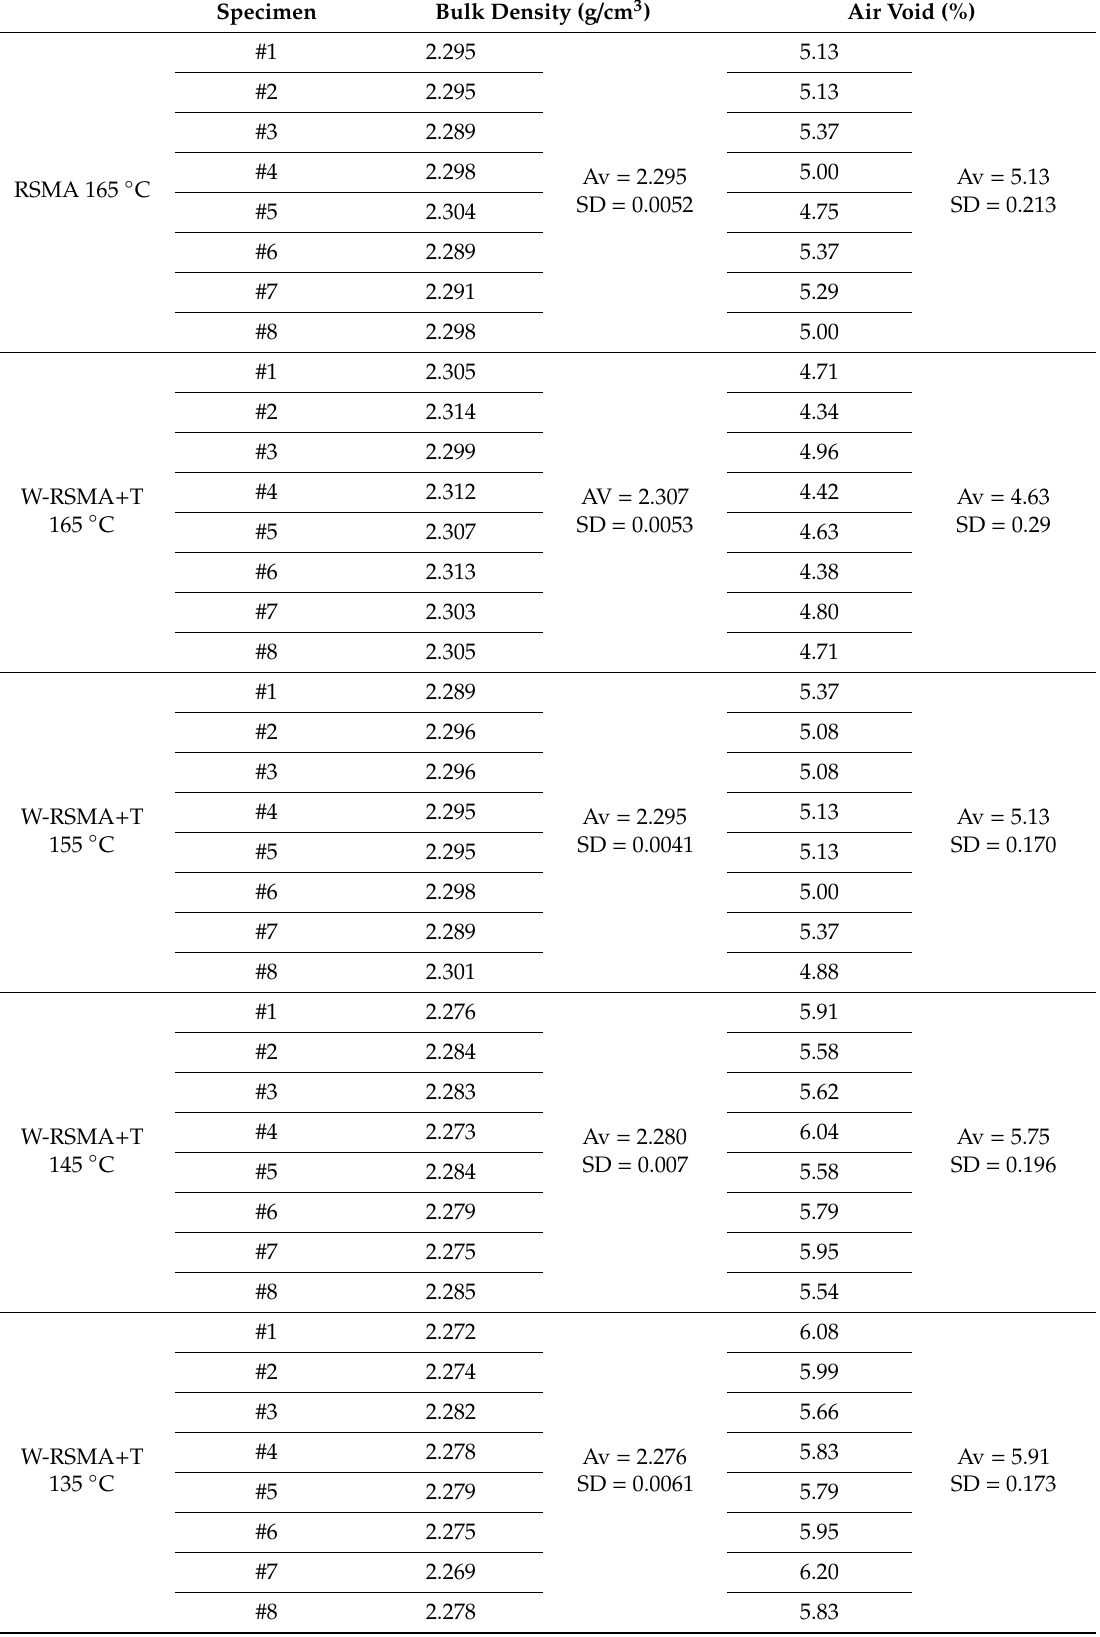
Table 5. Volumetric characteristics of the